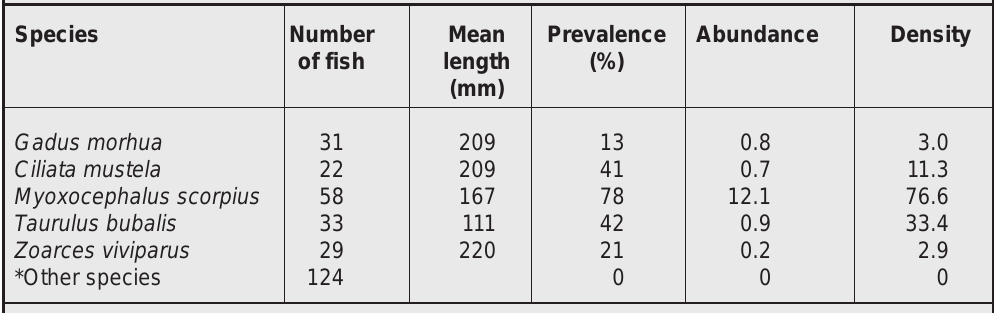
Table 1 . Infection parameters of Pseudoterranova decipiens in a sample of 297 fish caught with fyke nets, during 1991 to 1993 in Skagerrak. Abundance is defined as the mean number of sealworms in all fish (i.e. non-infected fish are included), prevalence as the proportion of fish infected and density as number of parasites kg -1 host round weight.